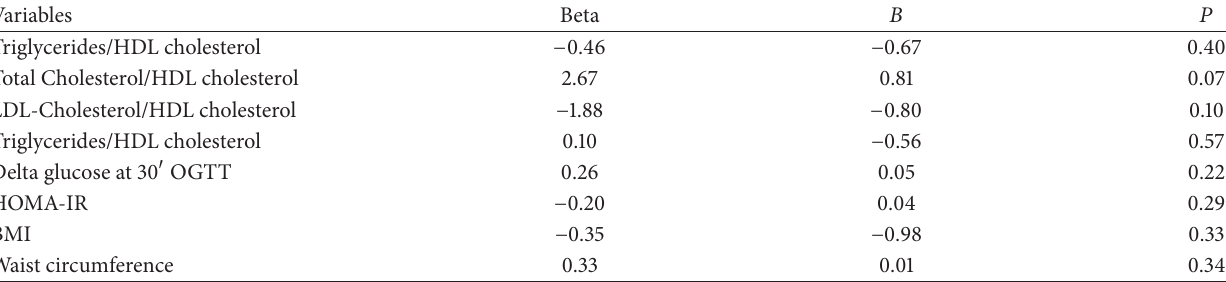
Table 3: Multivariable regression analysis for dependent variable HbA1C in women with pt2DM. Variables Beta 𝐵 Triglycerides/HDL